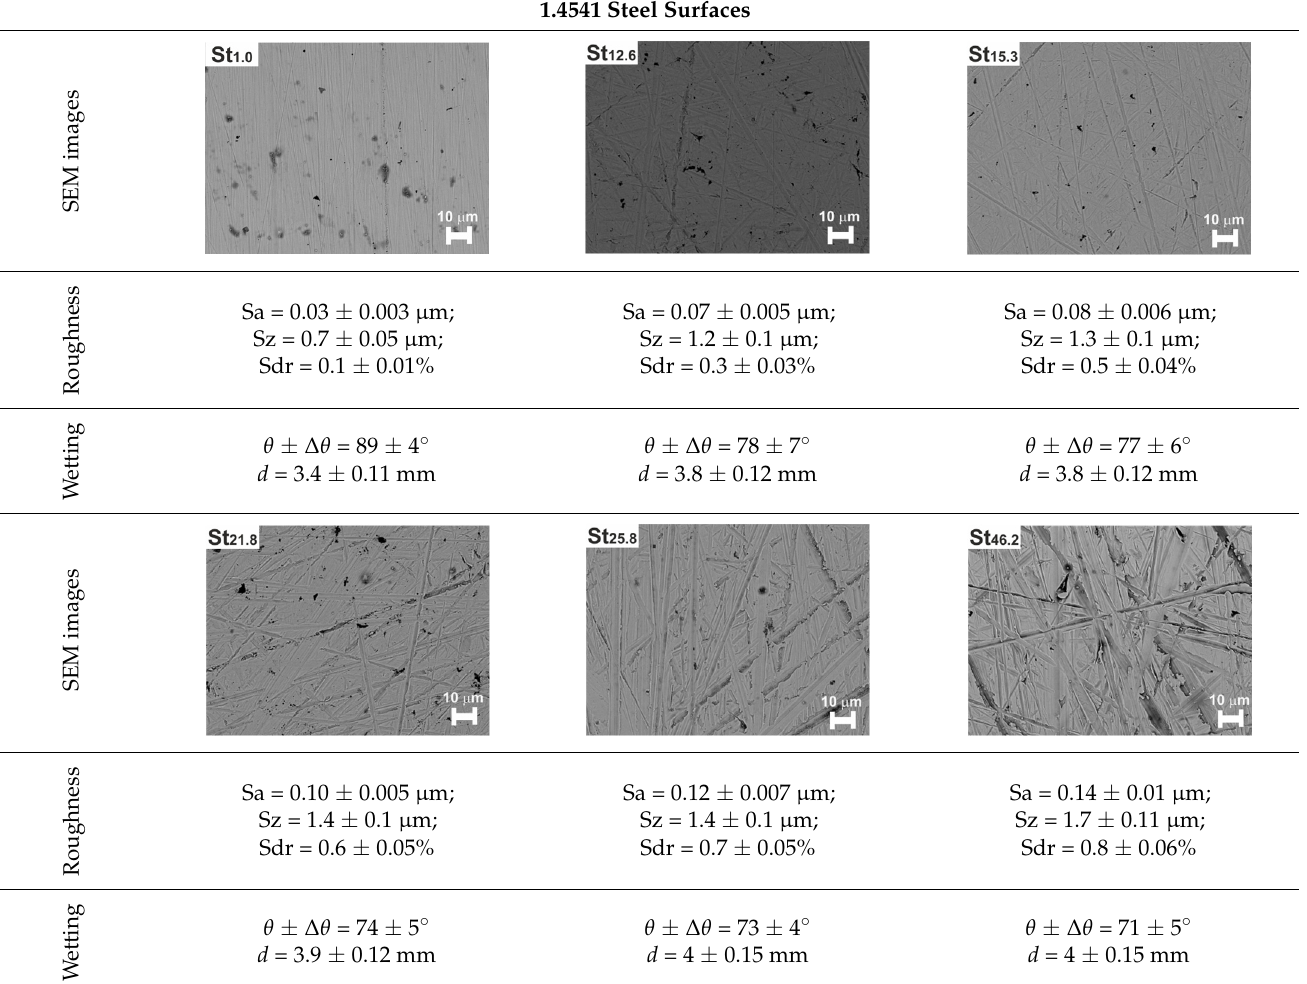
Table 2. SEM images and parameters characterizing roughness and wetting of steel surfaces.